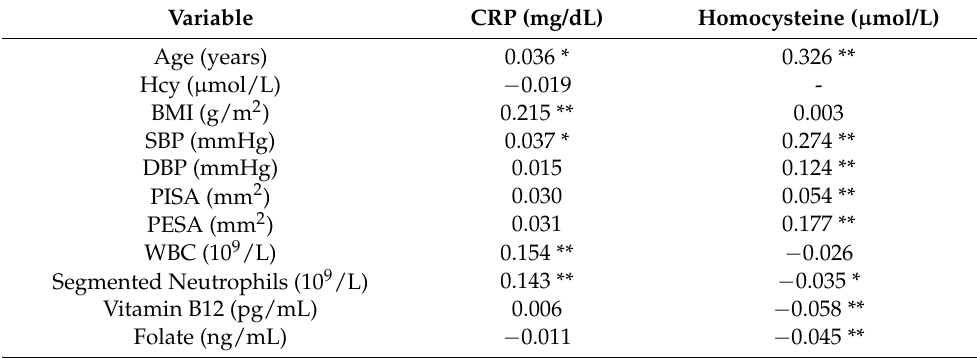
Table 2. Correlation of CRP and Hcy with sociodemographic and clinical variables ( n =